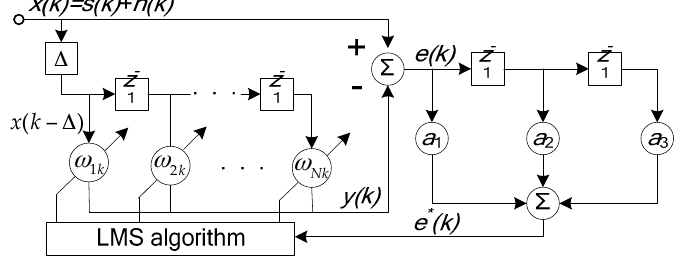
Figure 12. The schematic diagram of adaptive line spectrum enhancer (ALE).